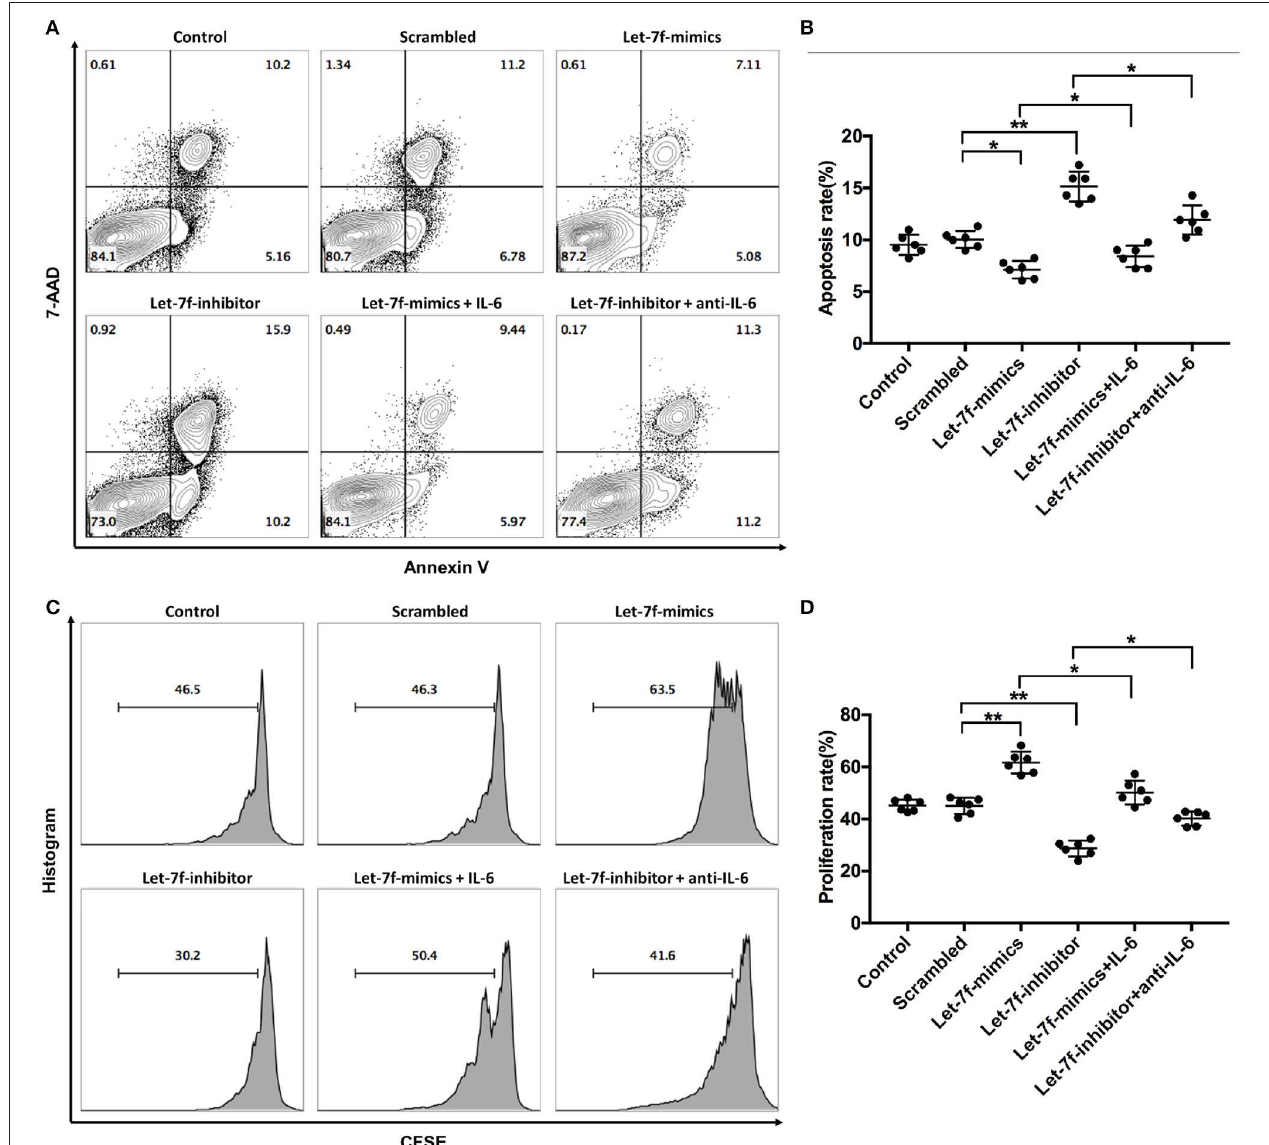
FIGURE 3 | Let-7f affects BM-MSCs proliferation and apoptosis in vitro . (A,B) Apoptotic status of normal non-tranfected BM-MSCs (Control), normal BM-MSCs tranfected with let-7f scrambled oligonucleotides (Scrambled), Let-7-mimics, or Let-7-inhibitor with or without the presence of recombinant human IL-6 (50ng/ml) or anti-human IL-6 antibody (30 µ g/ml) by annexin V and 7-AAD staining assay. Dot plots showing the frequency of Annexin V + 7-AAD + late apoptotic cells of BM-MSCs among different groups. (C,D) Proliferation status of BM-MSCs among the six groups by CFSE assay. All data are mean ± SEM. n = 6, * P < 0.05, ** P <